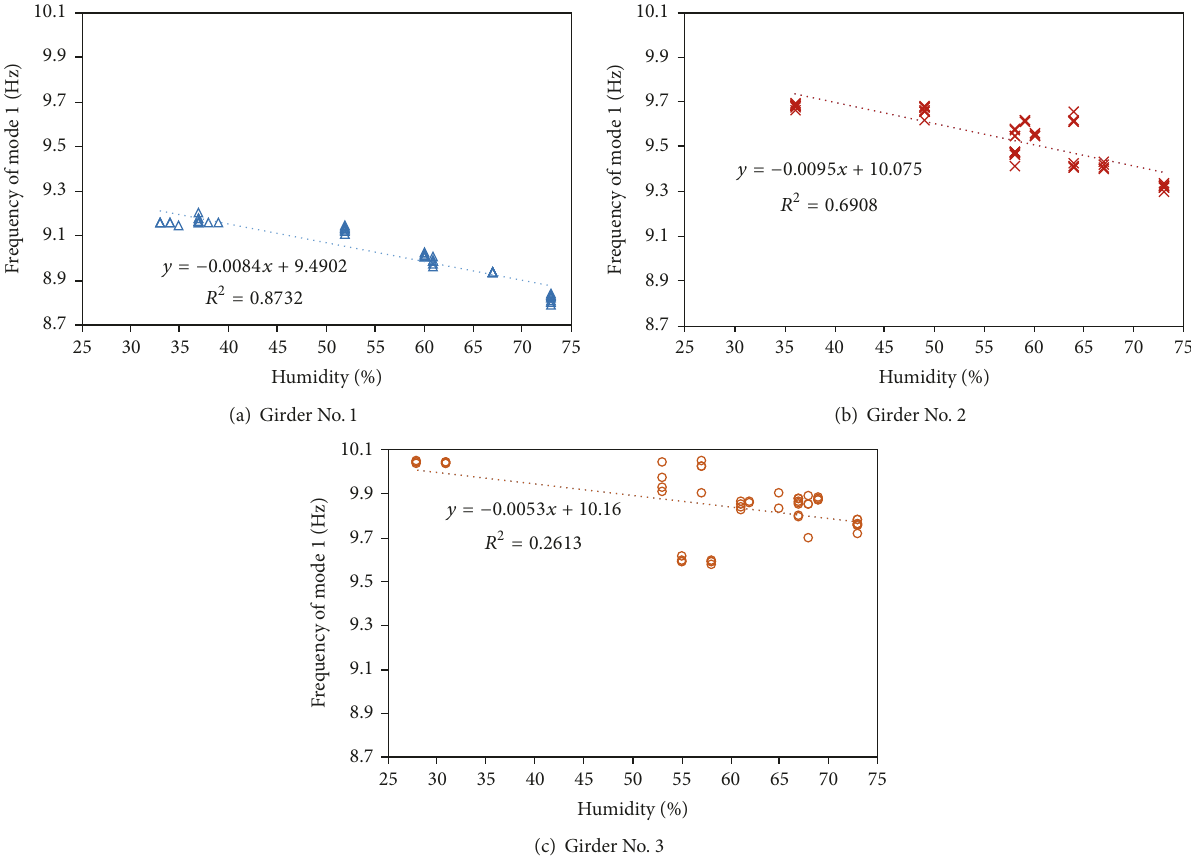
Figure 10: ((a)–(c)) Relation of frequencies of mode 1 to